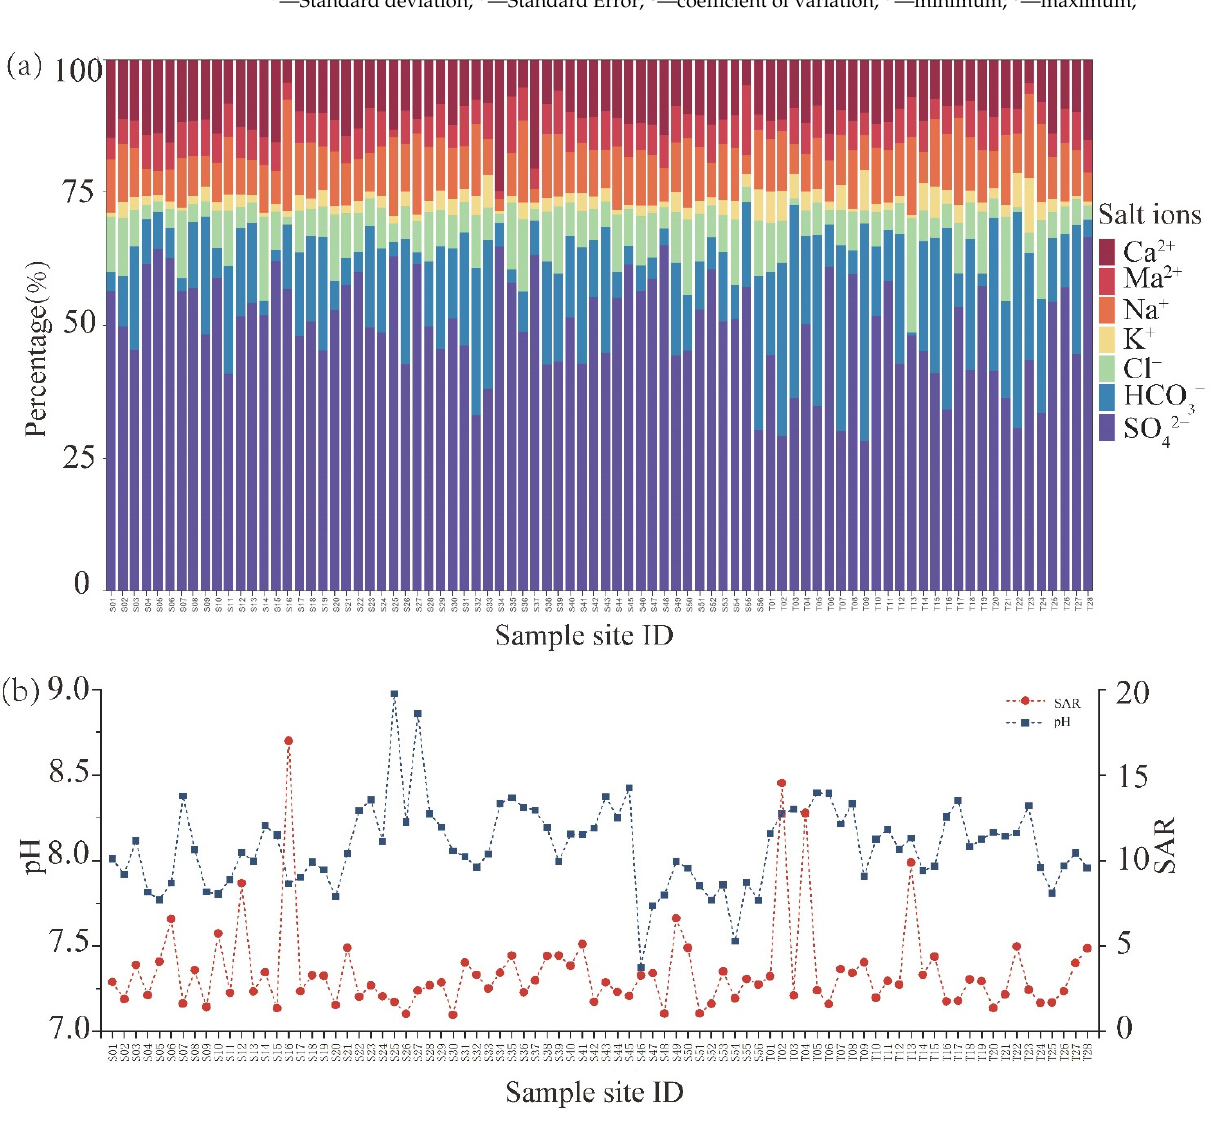
Figure 2. ( a ) Percentage stacked bar chart of salt content; and ( b ) pH and SAR of sample sites. Comparing the CV for all ions, the coefficient of variation was highest for Na + and Cl − , both of which showed strong variability (Table 3). The reason for this may be that the movement of soil salinity and moisture are interconnected. Cl ‐ is the monovalent anion, and it is mostly driven by water, which means that it is difficult to form compounds with other ions that are not easily adsorbed by soil colloids. The small hydration radius of Na + causes it to be weakly adsorbed by soil colloids, in addition to which the high content of Na + causes it to be one of the most active ions. However, HCO 3 − , SO 42 − , Ca 2+ , and Mg 2+ are influenced by properties such as ionic charge number, hydration radius, ionic concentra ‐ tion, and selective plant uptake, and have a high adsorption capacity for soil colloids. The salt ions had relatively little spatial variation and were more uniformly distributed in the surface soil than Na + and Cl − [42]. Statistical results showed large fluctuations in the main salt ions, which indicates that soil salt ions accumulated in the surface layer, under the influence of natural conditions and anthropogenic activities [43]. In addition, the ions SO 4 2 − and Ca 2+ have low stressing effects on plants, and the ions Na + and Cl − have a more serious effects on plant growth [44,45]. Soil pH is the basic standard for measuring soil acidity and alkalinity. The average pH of the soil in the study area was higher than 8 (Table 3), indicating that the soil is weakly alkaline. In addition, the average SAR was 3.49, and the range was 0.97–16.99